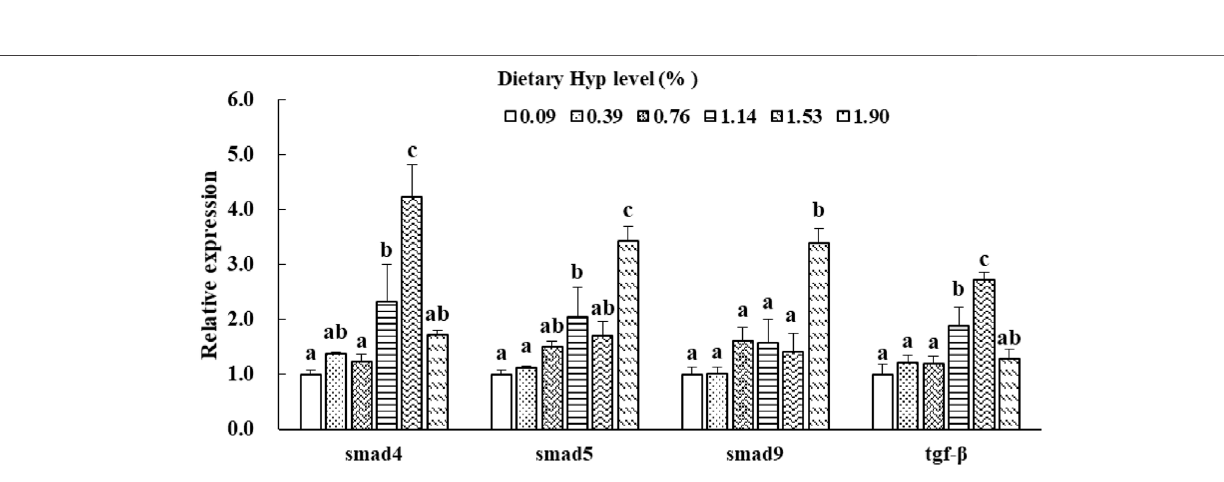
Frontiers in Physiology |